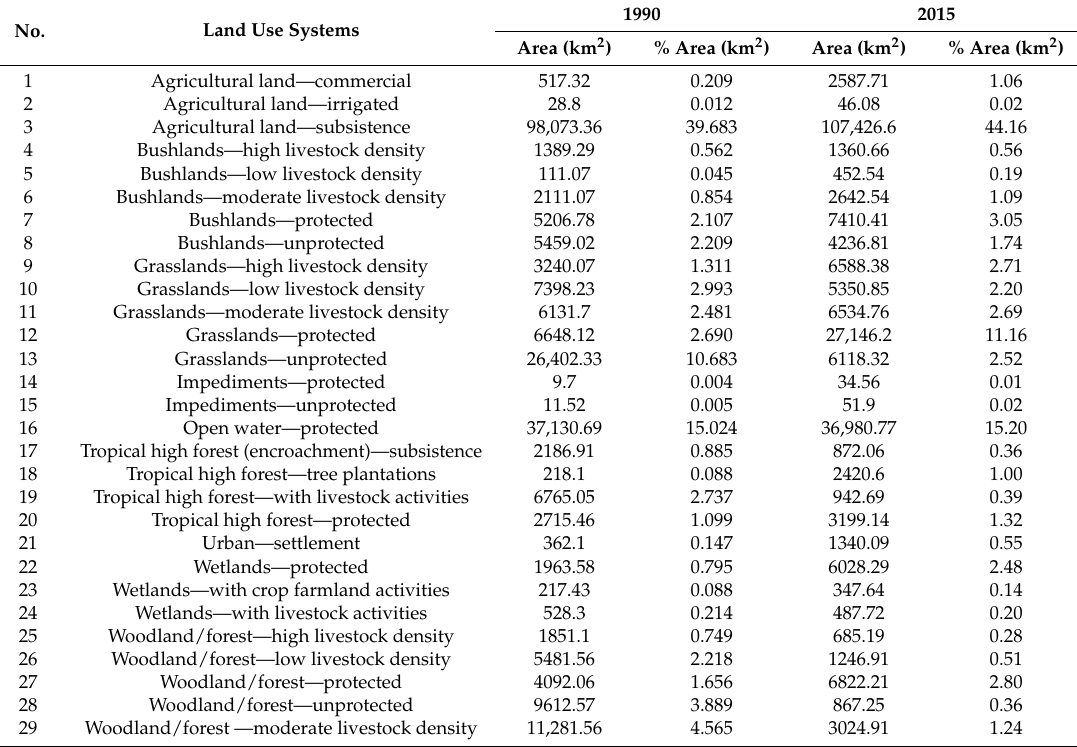
Table 3. Changes in the extent of land use systems coverage between 1990 and